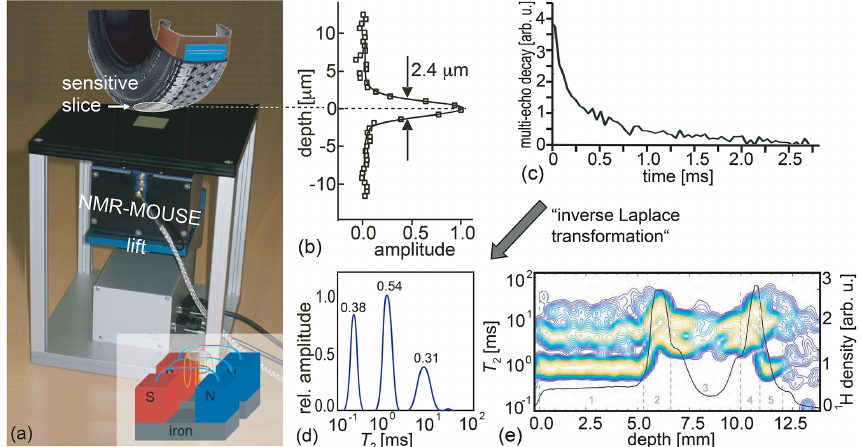
Figure 1. The principle of measuring depth profiles with the Profile NMR-MOUSE. (a) Conceptual picture of the Profile NMR-MOUSE on a lift with its sensitive slice inside a rubber tire. (b) Point-spread function of the record depth resolution. (c) Experimental signal decay measured with a multi-echo train. (d) Distribution of relaxation times from tire-tread rubber derived by inversion of a signal decay with an algorithm, referred to as “inverse Laplace transformation”. (e) Collection of distributions of relaxation times and signal amplitudes reporting nominal spin density measured across a range of 14mm into a tire